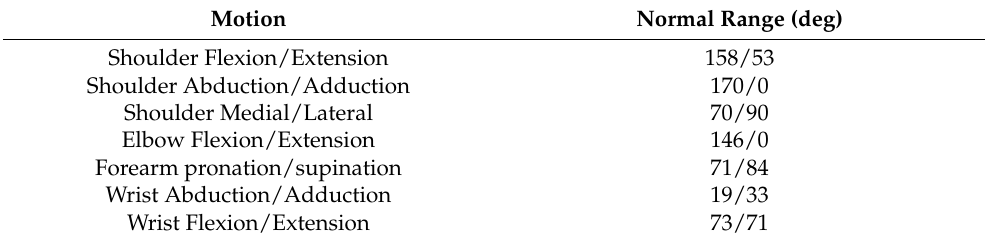
Table 1. Range of motion of the upper limb joints on the normal male